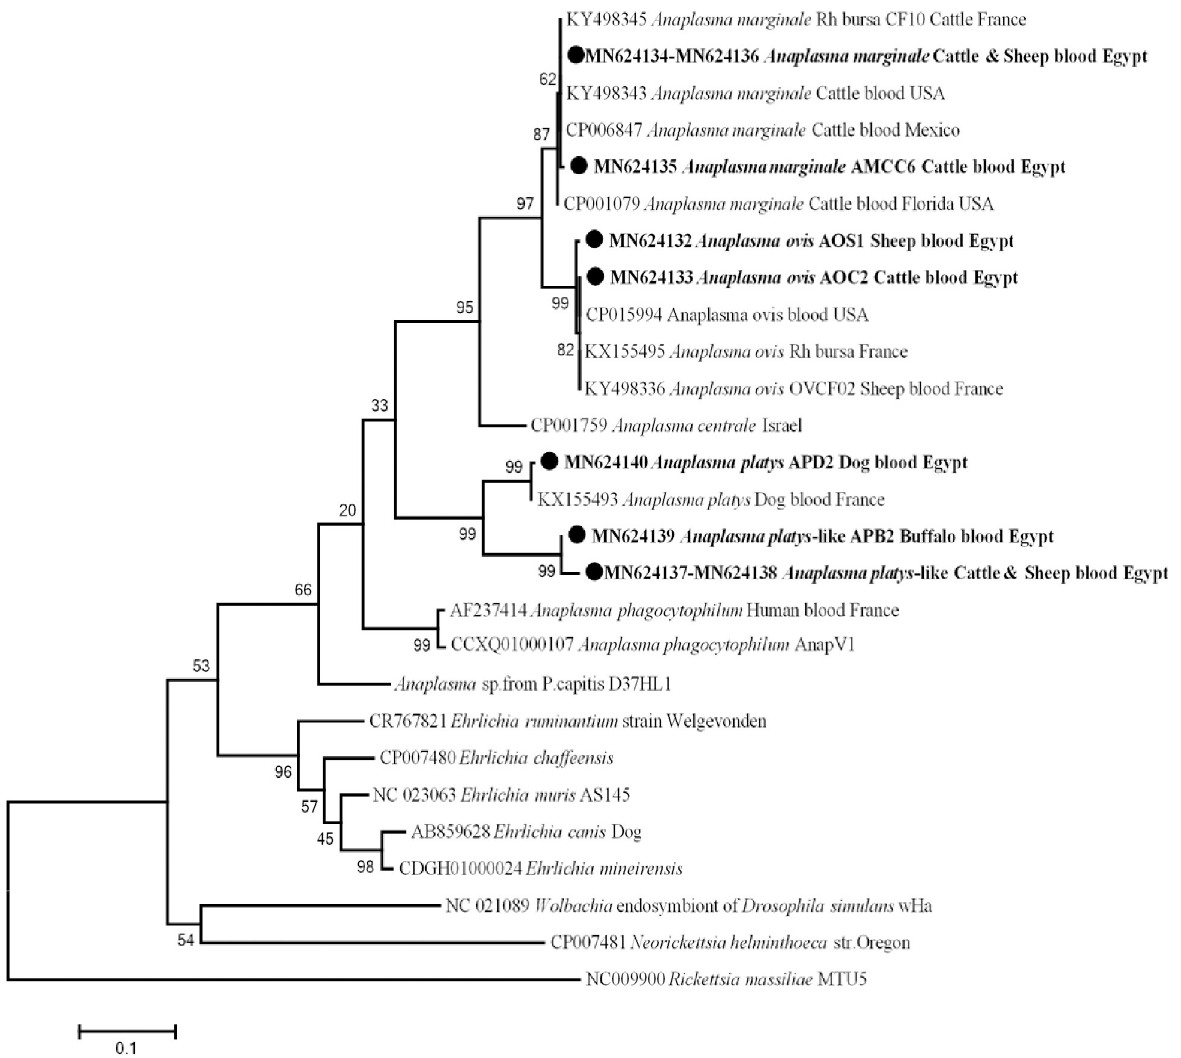
Fig 4. rpoB gene based phylogenetic analysis of genotypes identified in this study. Phylogenetic tree highlighting the position of Anaplasma sp. in the present study ( Bold ) related to other Anaplasma sp. and Ehrichia sp. available in GenBank. The sequence of rpoB gene were aligned using CLUSTAL W and phylogenetic inferences were constructed in MEGA X using Maximum Likelihood based on Tamura-Nei Model for nucleotide sequences with 500 bootstrap replicates. There was a total of 534 positions in the final dataset. The scale bar represents a 10% nucleotide sequence